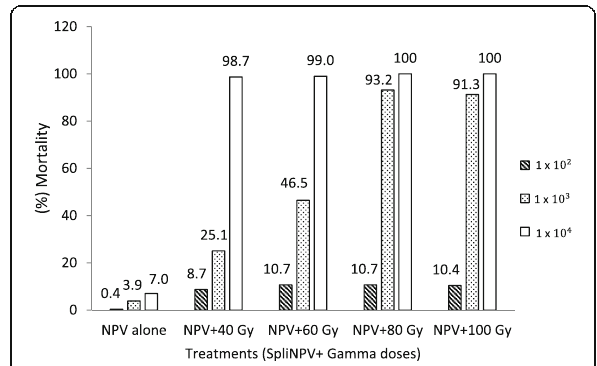
Fig. 1 Effect of 1 × 10 2 , 1 × 10 3 , and 1 × 10 4 PIBs/ml concentrations of SpliNPV on S. littoralis third-instar larvae resulted from males irradiated as full-grown pupae with sub-sterilizing doses 20, 40, 60, and 80 Gy in comparison to un-irradiate ones (virus alone). Data are expressed as mean values of five replicates per treatment